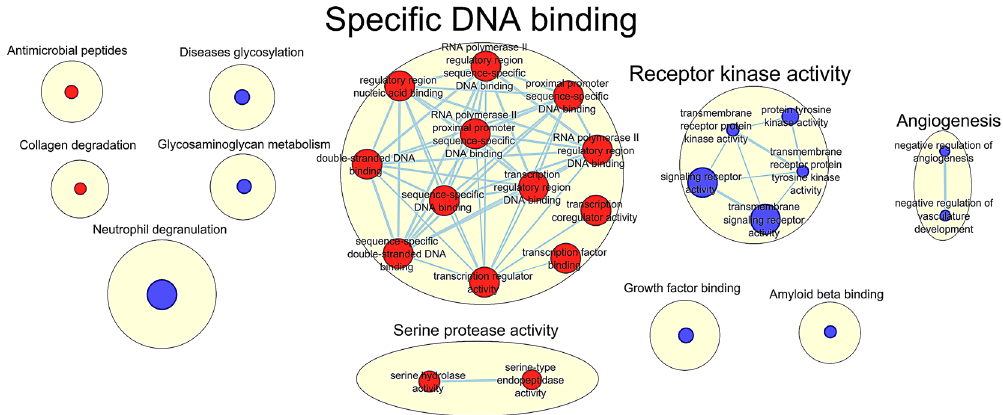
Figure 3. Enriched Reactome and Gene Ontologies (biological processes and molecular functions) pathways in the proteomic data. 5 Reactome pathways, 21 GO molecular functions, and 2 GO biological processes were significantly enriched (q-value < 0.25). Red circles: upregulated processes in patients with progression of WMH; blue circles: downregulated processes. 5 pathways were significantly enriched (at q-value < 0.25) regarding the Reactome, 21 considering GO molecular function and 2 considering GO biological processes. This figure was constructed with Cytoscape software (version 3.8.2, 2001–2018 Cytoscape Consortium, https:// cytos cape. org/). Annotations correspond to the most frequent words in each